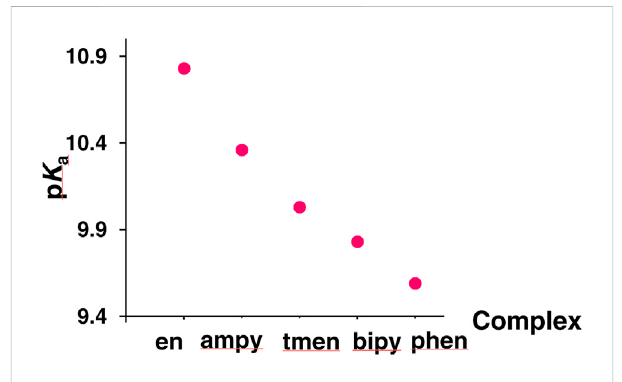
FIGURE 2 Acidic properties of examined